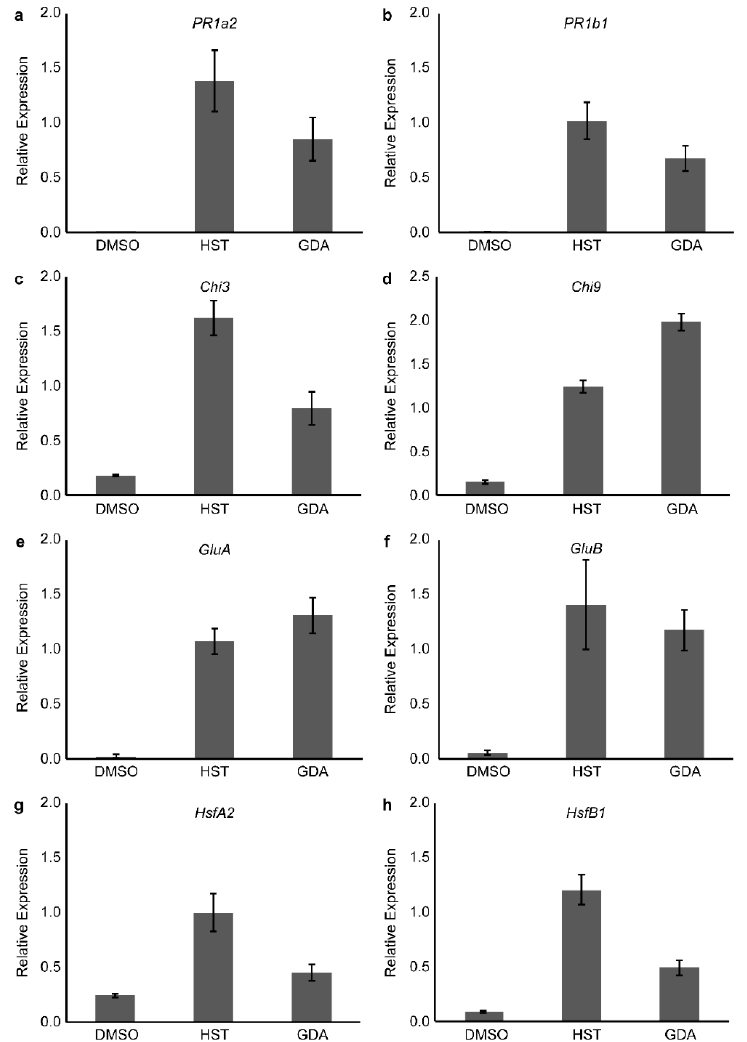
Figure 8. Relative expression level of PR ( a , b , c , d , e , f ) and Hsfs ( g , h ) genes in the leaves of the tomato cultivar Natsunokoma at 24 h after treatment with DMSO, HST, and GDA. 0.1% ( v / v ) DMSO and 10 µM GDA were manually applied by foliar spray. Gene expression levels were quantified by qPCR and normalized to GAPDH expression. Vertical bars indicate the standard error of the mean ( n = 4).